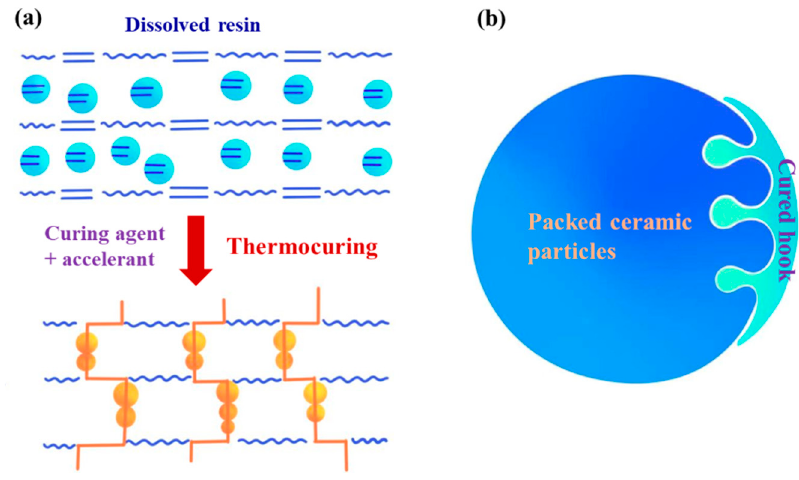
Figure 6. Schematic diagrams of ( a ) resin crosslinking and curing and ( b ) the interlocking effect between pores of packed particles and cured resin hooks. Table 4. Moh’s hardness and wear resistance of artificial stone with different ceramic waste